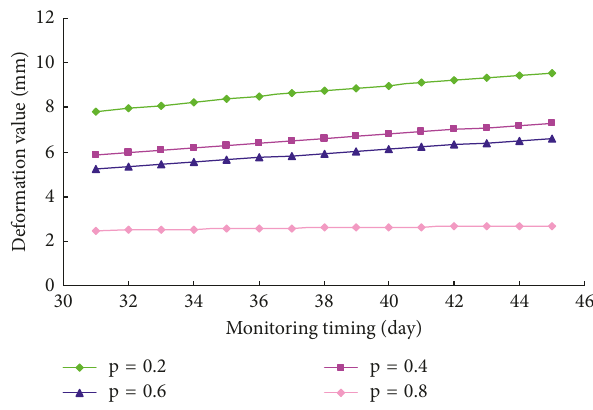
Figure 6: Parameter p sensitivity analyses of the JC-2 monitoring